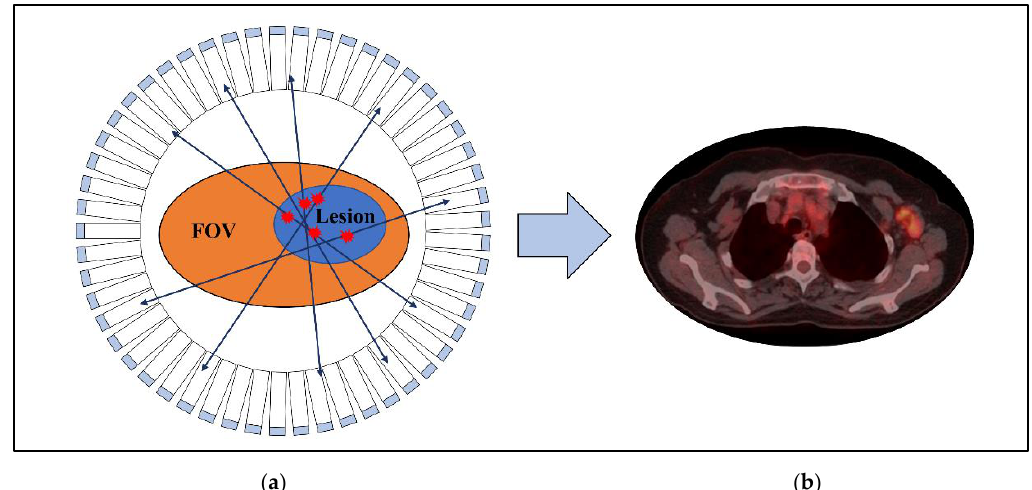
Figure 2. ( a ) Principle of PET scanner imaging, the circle composed of rectangles represents the detector blocks, the orange area represents the FOV, the blue area represents the lesion, the arrows represent the LORs; ( b ) example of a PET image after attenuation correction [39].